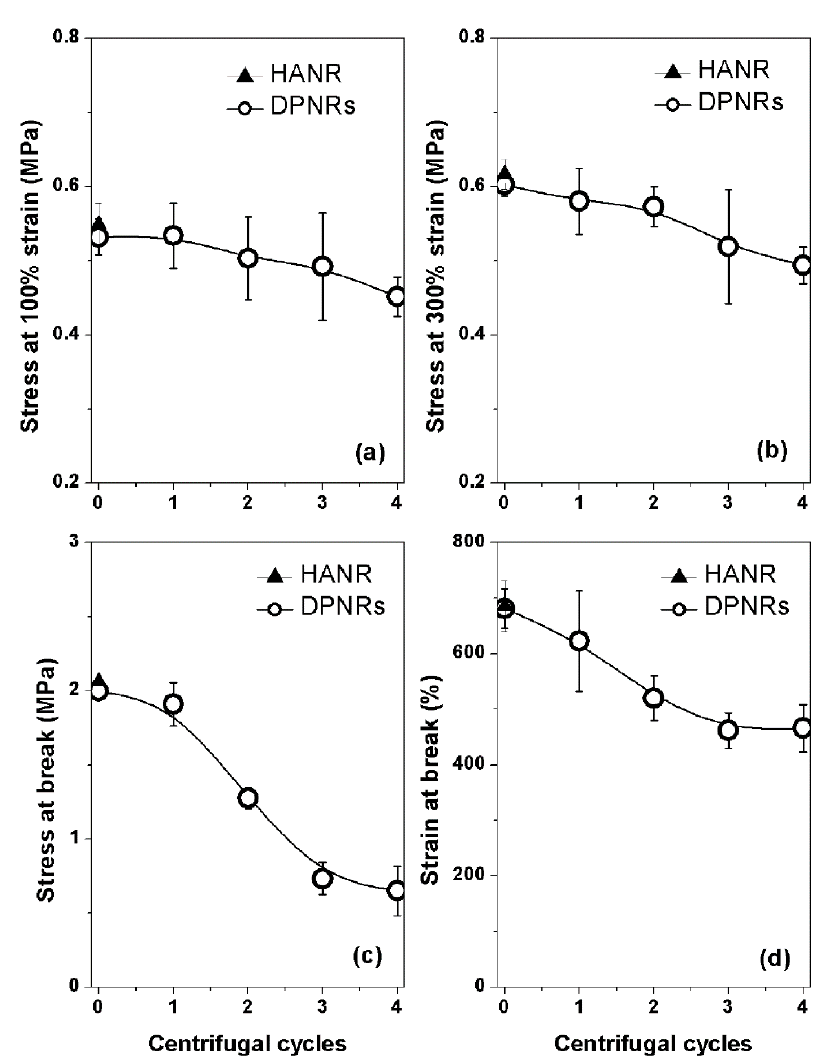
Figure 7. ( a ) stress at 100% and ( b ) 300% strains, ( c ) stress at break, and ( d ) strain at break of HANR and the